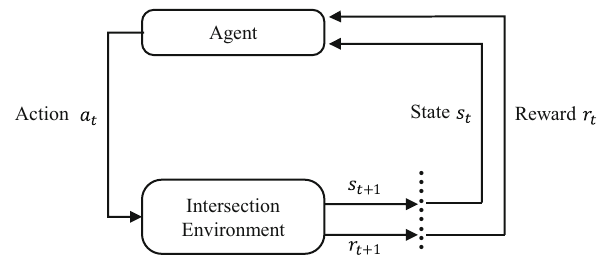
Fig. 2 Agent and environment interaction